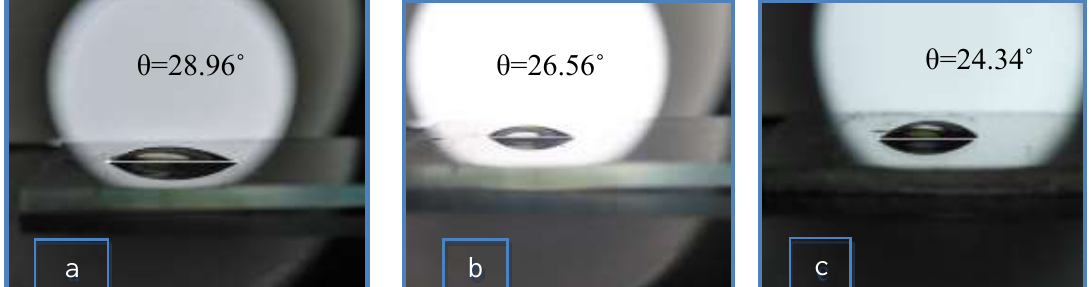
Fig.01a: Images of water droplet on the sample pure TiO b- after15 min. of UV irradiation c- an hour UV